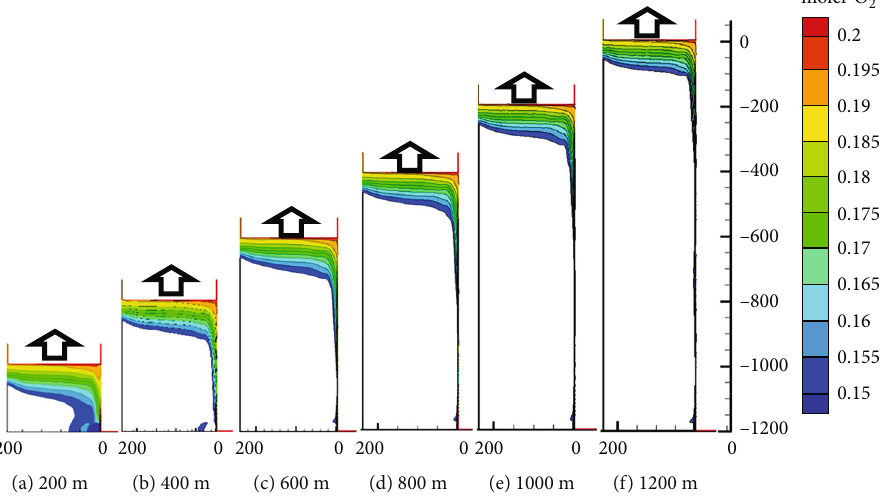
Figure 12: Distribution of dangerous areas in the goaf after nitrogen injection.